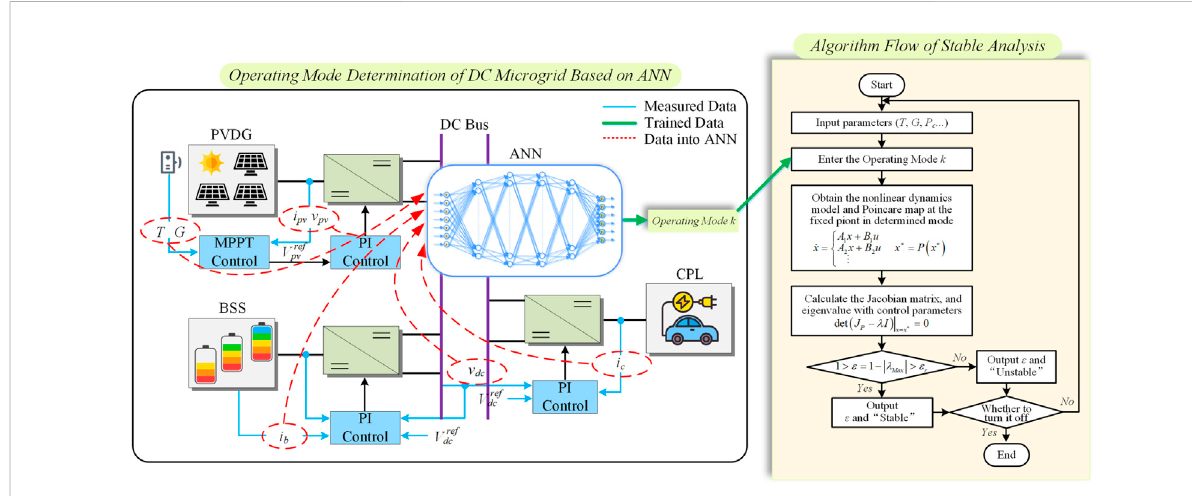
FIGURE 4 The framework of the proposed ANN-aided nonlinear voltage stability monitor method.